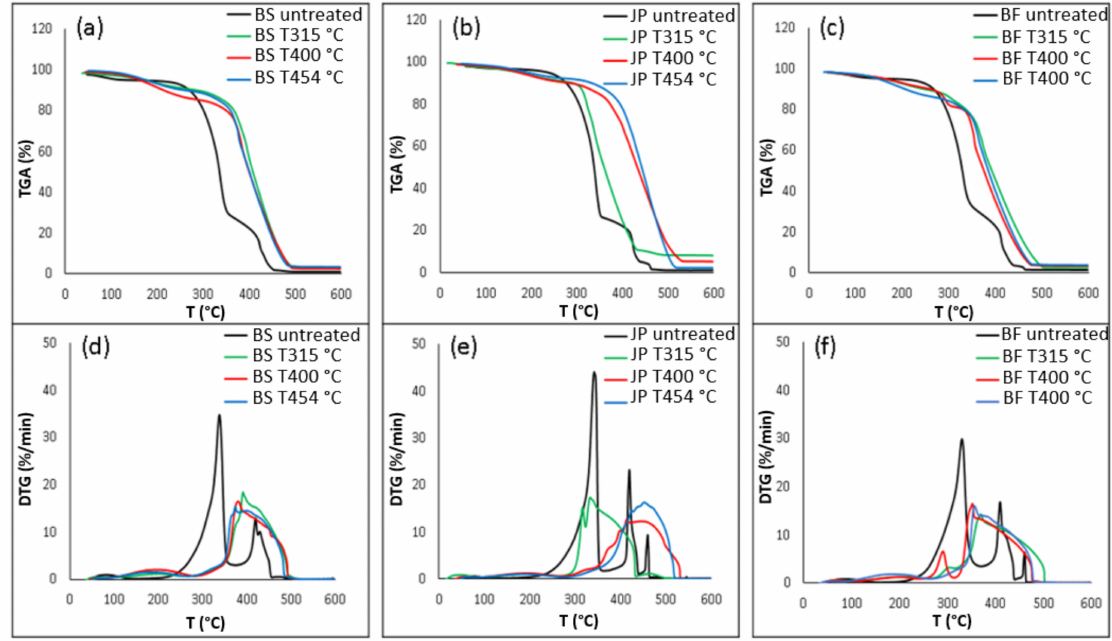
Figure 6. Thermogravimetric analyses curves (TGA and DTG) of pellets derived from the three types of wood: JP ( a , d ), BF ( b , e ), and BS ( c , f ) at different heat